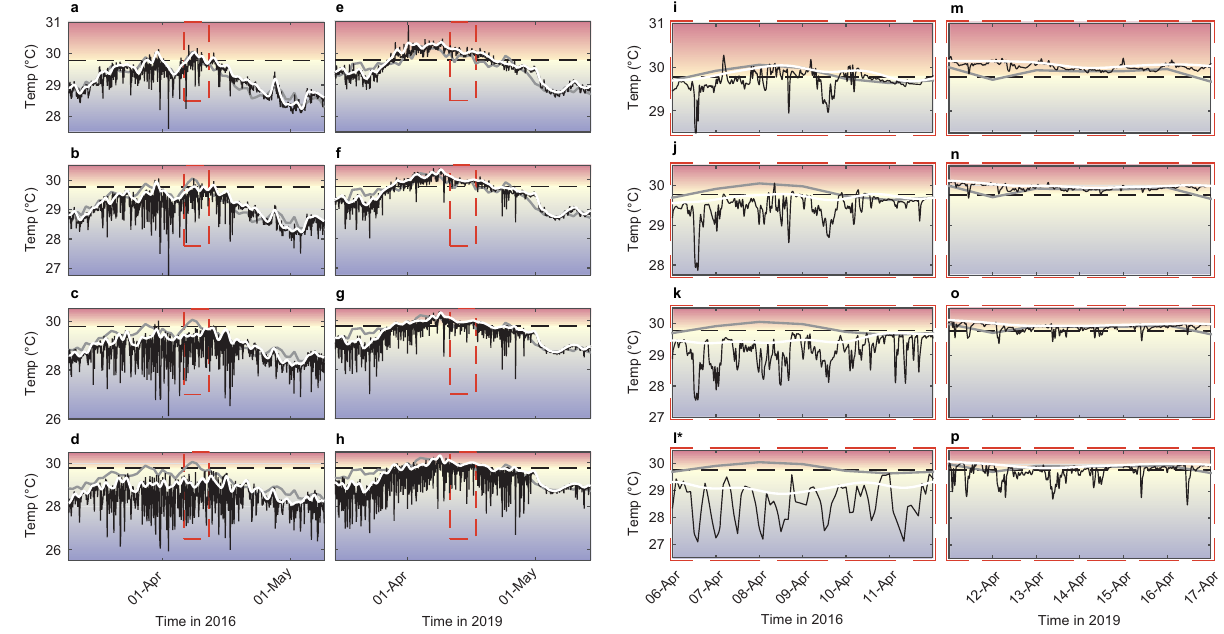
Fig. 3 | Contrasting reef-level temperature variations across depths on Moor- ea ’ snorthshoreduringthe2016and2019marineheatwaves. Panelsontheleft show the observed high-frequency water temperature variations (black lines, measuredat2-minintervals)duringthehottestmonths(Apr – May)in a – d 2016and e – h 2019 at a , e 10, b , f 20, c , g 30 and d , h 40m depths. Right panels focus on relativevariationduringtheheatwavepeaksacrossthesamedepths: i – l *06 – 12Apr 2016 and m – p 11 – 17 Apr 2019. Non-internal-wave temperature variations are shown based on observed temperatures fi ltered to remove the high-frequency